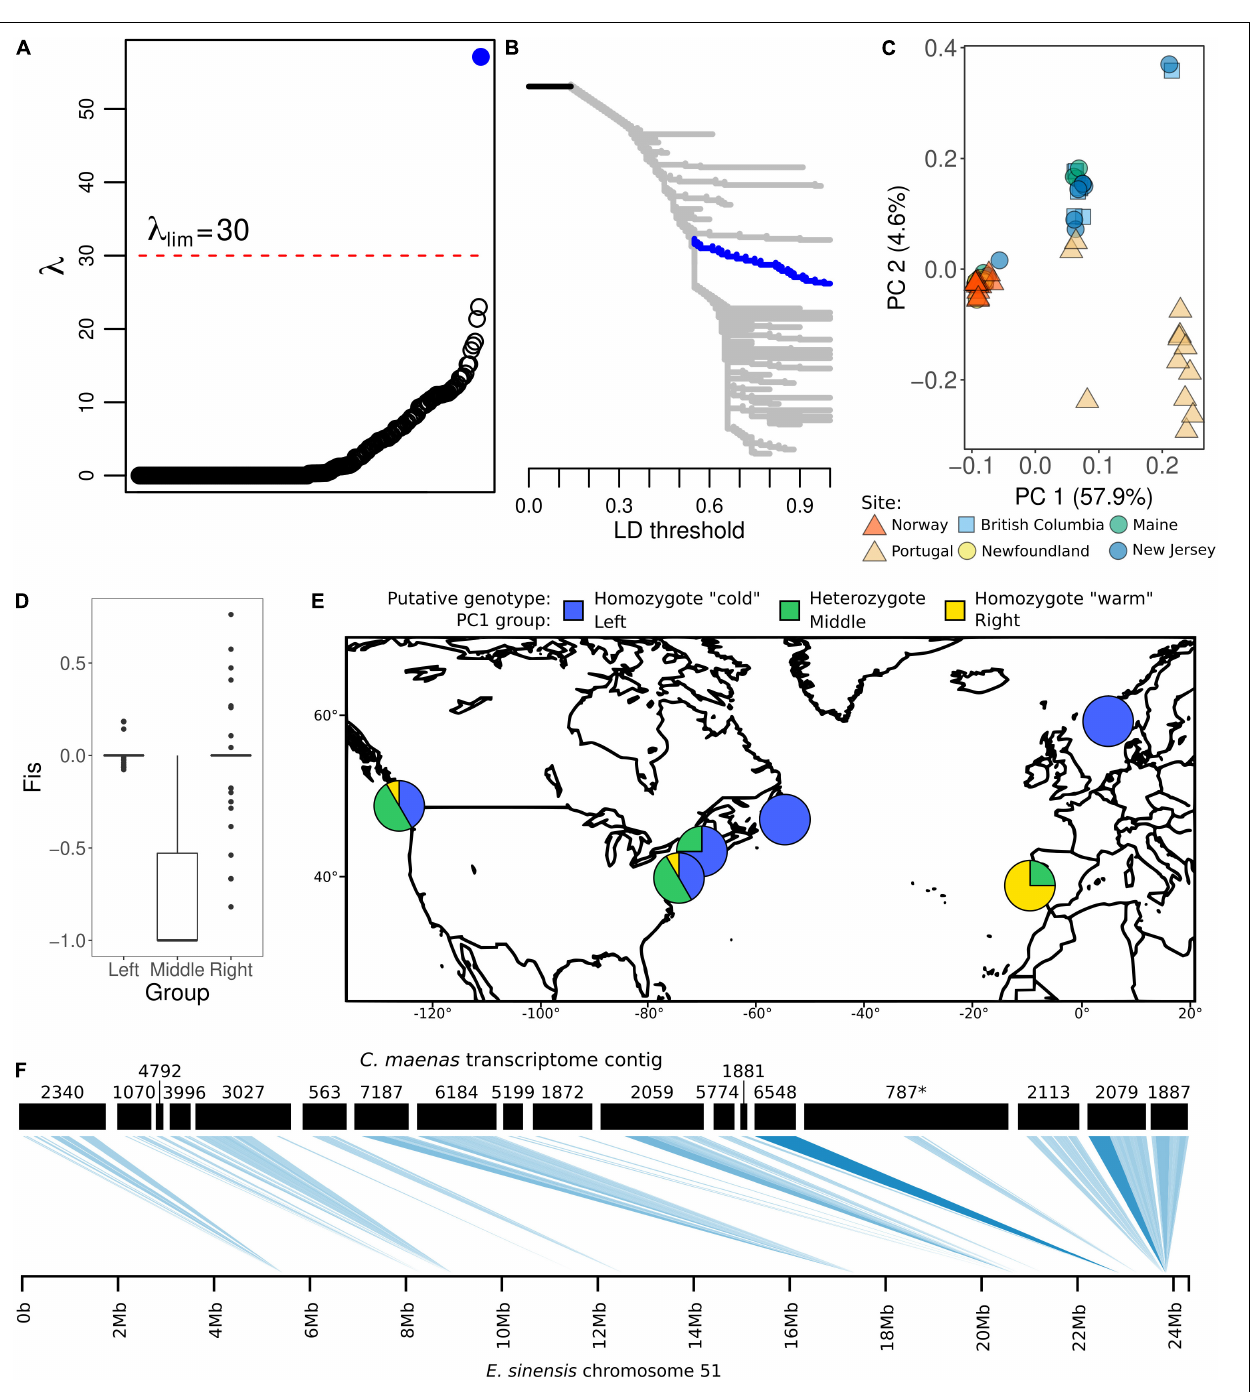
FIGURE 3 | Linkage disequilibrium analysis. (A,B): LDna analysis of full 10,790 SNP set, using 45 edges and λ = 30. (A) shows all detected clusters ranked by λ value, where higher λ indicates a more compact and closely associated cluster of SNPs. Clusters above the λ lim threshold are considered outliers. (B) shows a tree of SNP clustering based on pairwise R 2 values. In both (A,B) , dark blue indicates the large LD cluster including 72 outlier SNPs. (C): Principal Components Analysis of outlier SNPs in the 84-SNP LD cluster indicated in dark blue in (A,B) . Points represent individual crabs; color and shape indicate sampling site. (D): Boxplot of F IS values for outlier SNPs in the 84-SNP LD cluster indicated in dark blue in (A,B) , with individuals separated into three groups according to PC1 in (C) . For Left and Right groups, boxplots appear as lines because the box hinges (25th to 75th percentiles) and whiskers (box hinges ± 1.5*interquartile range) are the same as the median. (E): Map showing distribution of putative divergence island alleles in each sampled site. Pie charts represent proportion of putative genotypes, based on PC1 clustering in (C) . (F): Alignment to Eriocheir sinensis chromosome 51 of 18 contigs in the 84-SNP LD cluster indicated in dark blue in (A,B) . Shade indicates alignment e-value (palest blue = 1 − 10 ; darkest blue =